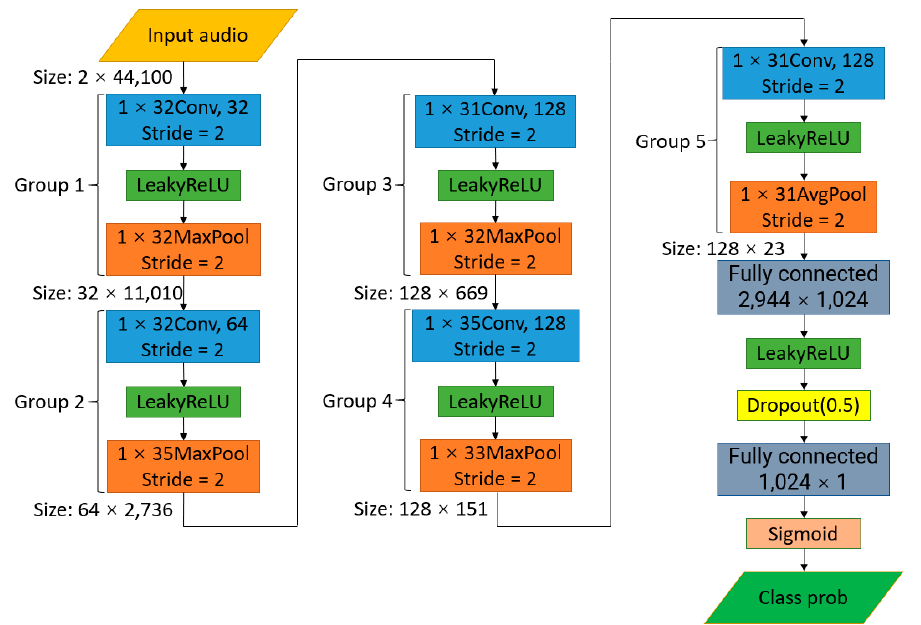
Figure 6. Architecture of deep end-to-end model. Stereo audio will first pass through five convolutional layers (group 1 to group 5—each convolutional layer contains 64 convolution kernels, LeakyReLU activation function and Max pooling, and the last layer uses average pooling). Then, the discriminant probability will be output through the three-layer fully connected layer and the sigmoid activation function. Size represents the size of the sample before it passes through each layer of the